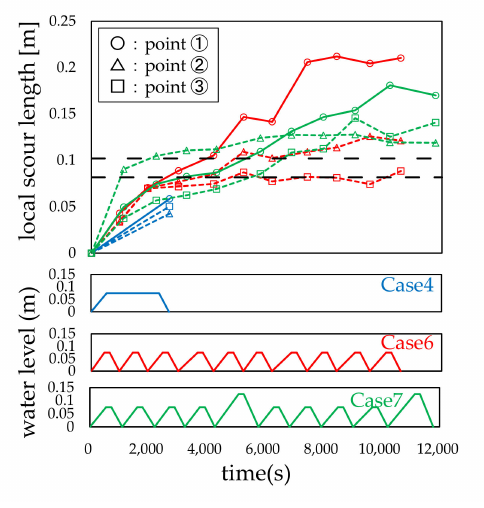
Figure 15. Local scour length of Cases 4, 6 and 7.